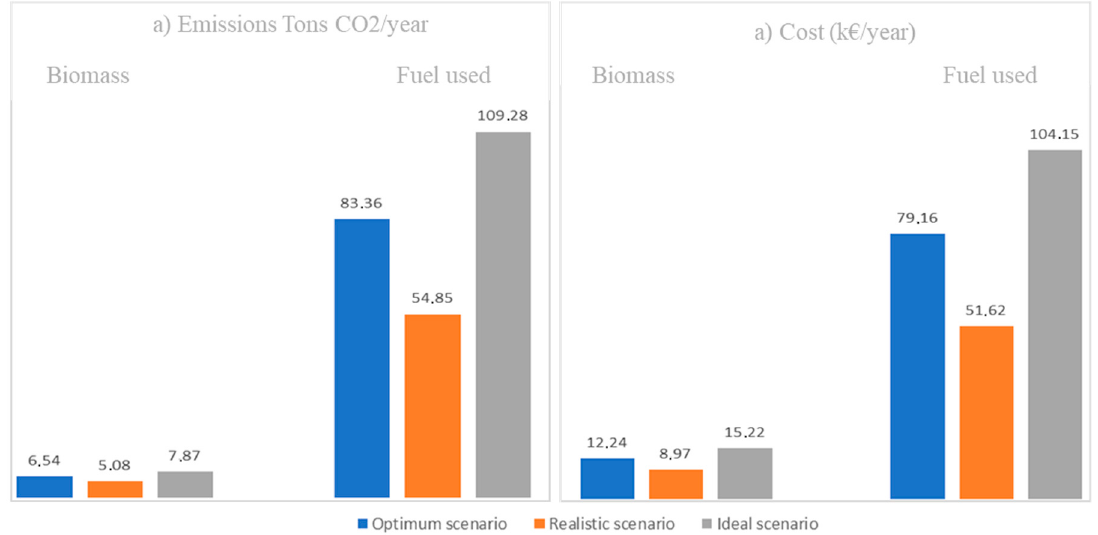
Figure 2. Comparative cost consumption and CO 2 emissions when biomass replaces the fuel used.